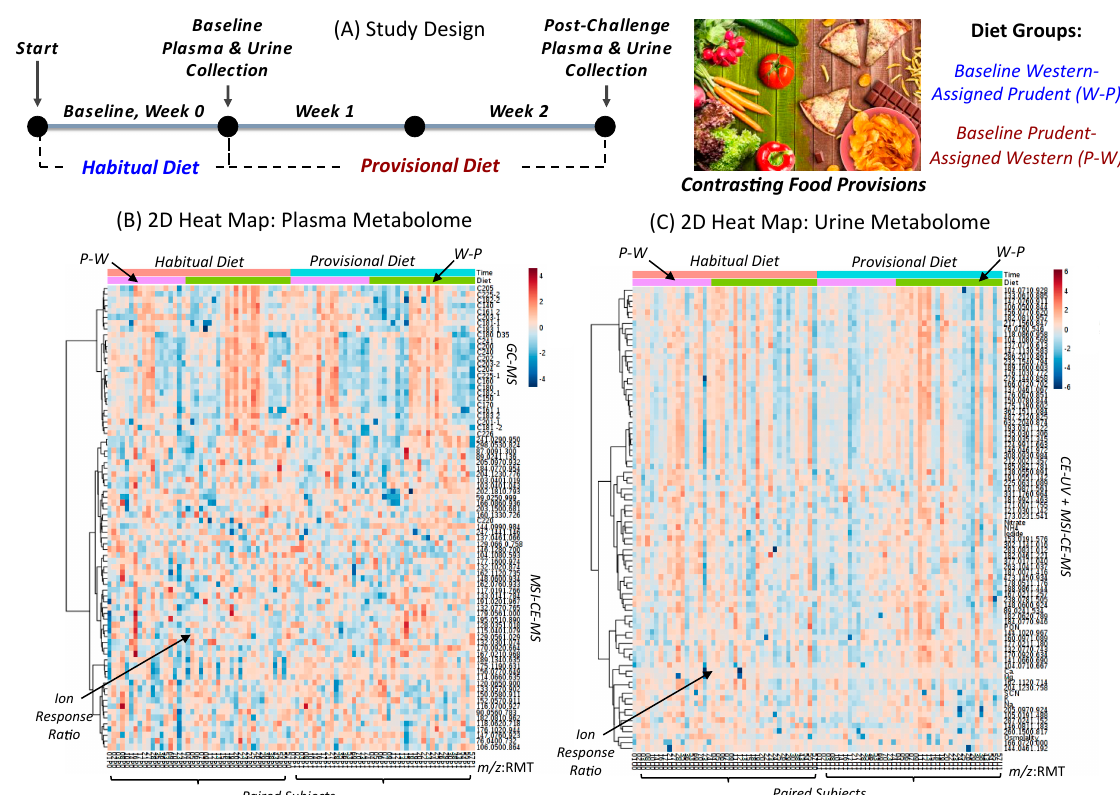
Figure 1. ( A ) Overview of study design in this parallel two-arm dietary intervention study involving participants ( n = 42) from the Diet and Gene Interaction Study (DIGEST) who were assigned a Prudent or Western diet with matching urine and plasma collected at baseline, and two weeks post-